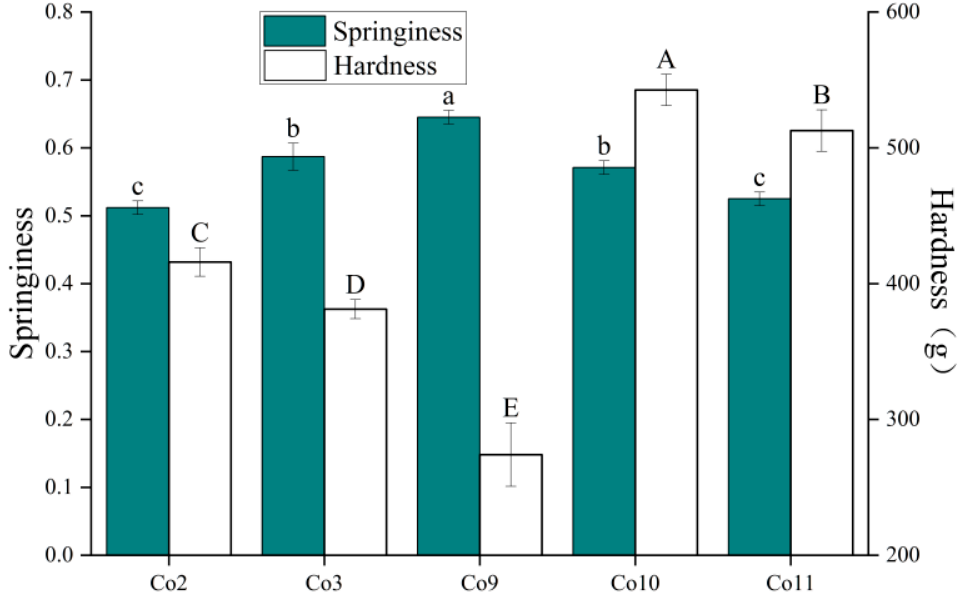
Figure 9. Texture properties of heat-induced gel of Co prepared under different extraction pH conditions. Note: Hardness of different samples with different capital letters has a significant difference ( p < 0.05), and the springiness of different samples with different lowercase letters has a significant difference ( p < 0.05).